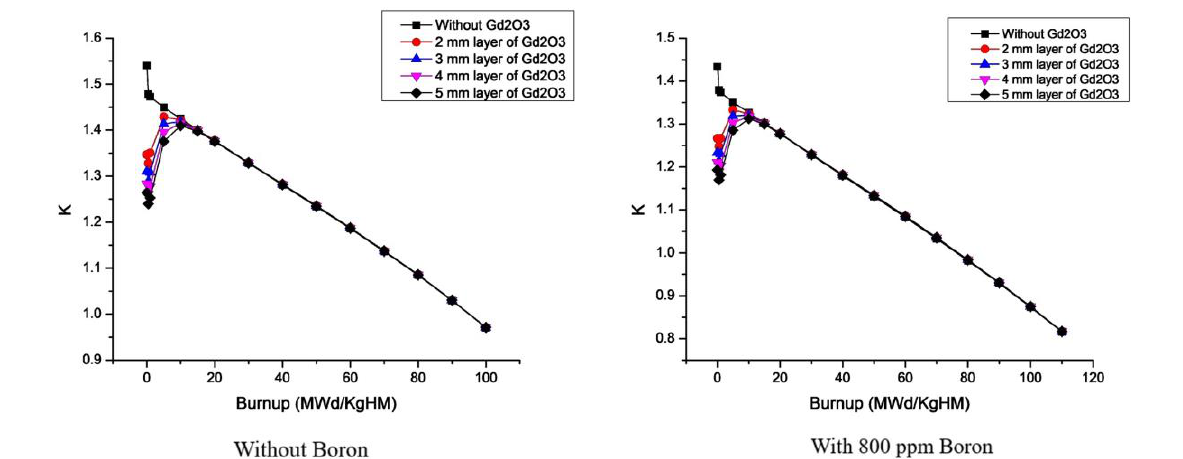
O as Burnable 2 3